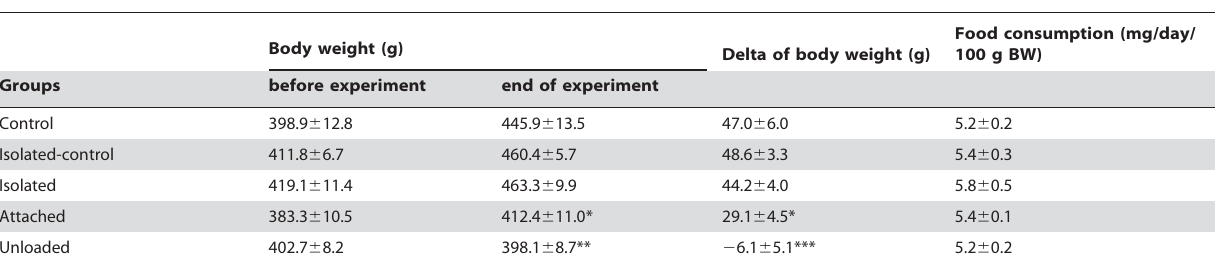
Table 1. Body weight and food consumption.